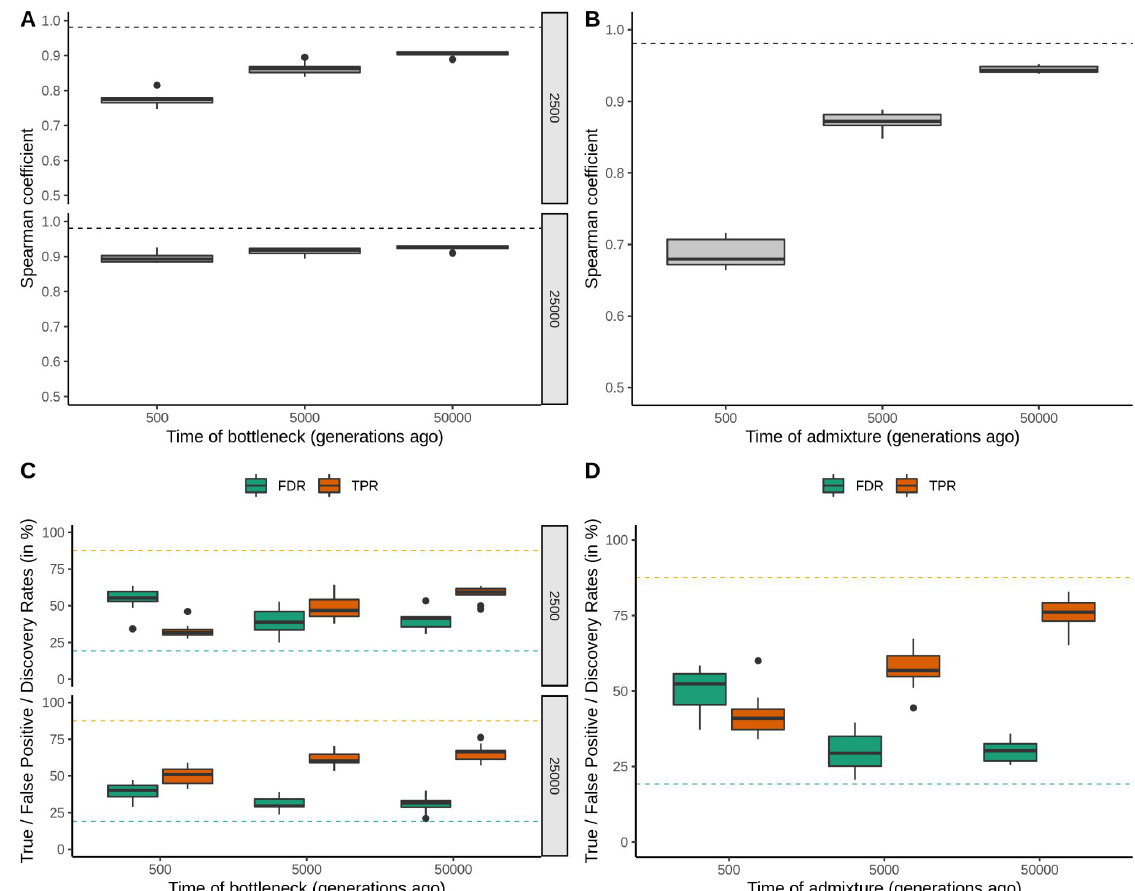
Figure 5 - Influence of bottleneck (left panels A and C) and admixture (right panels B and D) events on recombination rate inference and hotspot detection. Spearman correlation coefficients between simulated and inferred landscapes are shown as a function of the age of the bottleneck event and the strength of the bottleneck ( i.e. N b , the N e value during the 1000 generations of the bottleneck) ( A ), and as a function of the age of the admixture event ( B ). True positive (TP, in orange) and false discovery (FD, in green) rates of hotspots called using a detection threshold of 2.5, as a function of the time of the bottleneck event and the strength of the bottleneck ( C ), and as a function of the time of the admixture event ( D ). Dashed lines correspond to averaged Spearman’s rho, TPR and FDR values in populations that did not experience bottleneck or admixture